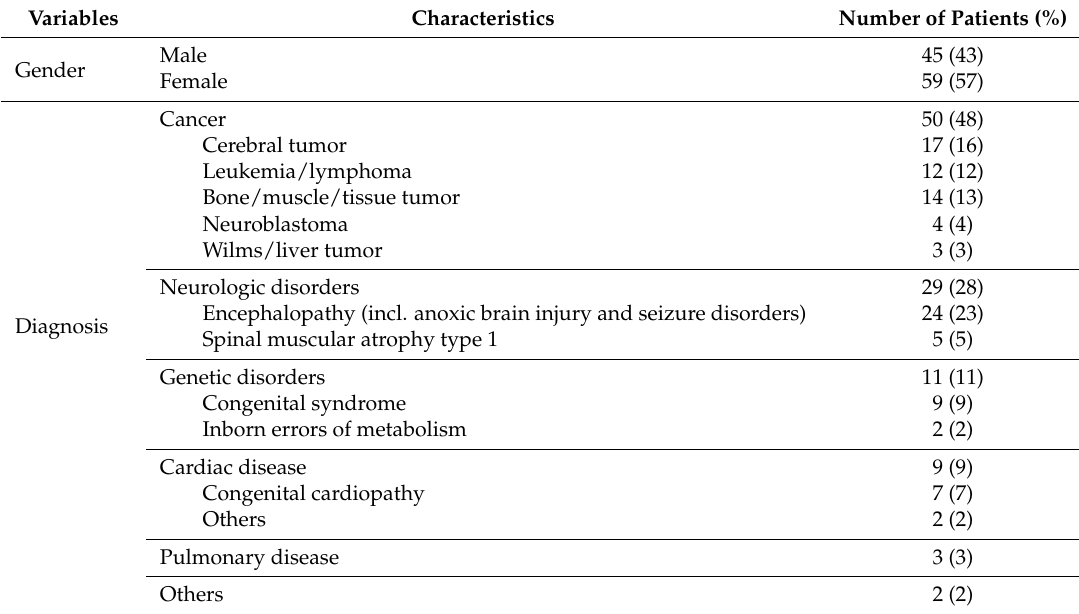
Figure 1. Patients with a valid OPD order at any time during the study period. Table 2. Patients characteristics ( n = 104).